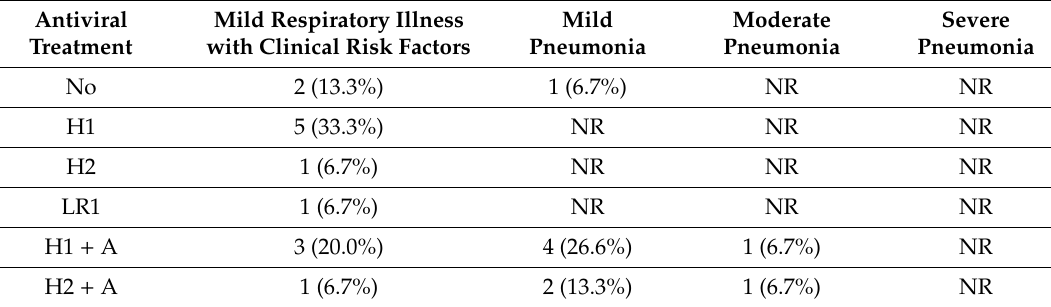
Table 2. Antiviral treatment protocols for coronavirus disease 2019 according to clinical